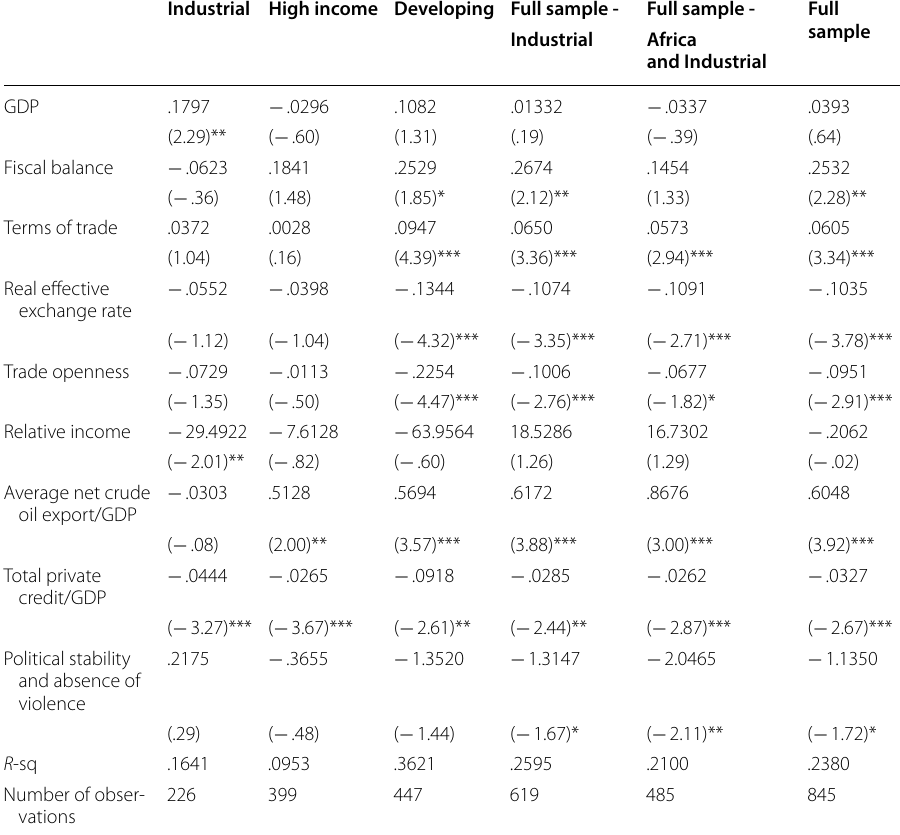
All variables are used in their first differences. t -statistics in parenthesis. *, **, *** indicate significance at 10%, 5%, 1%, respectively. The estimates for the constants are not